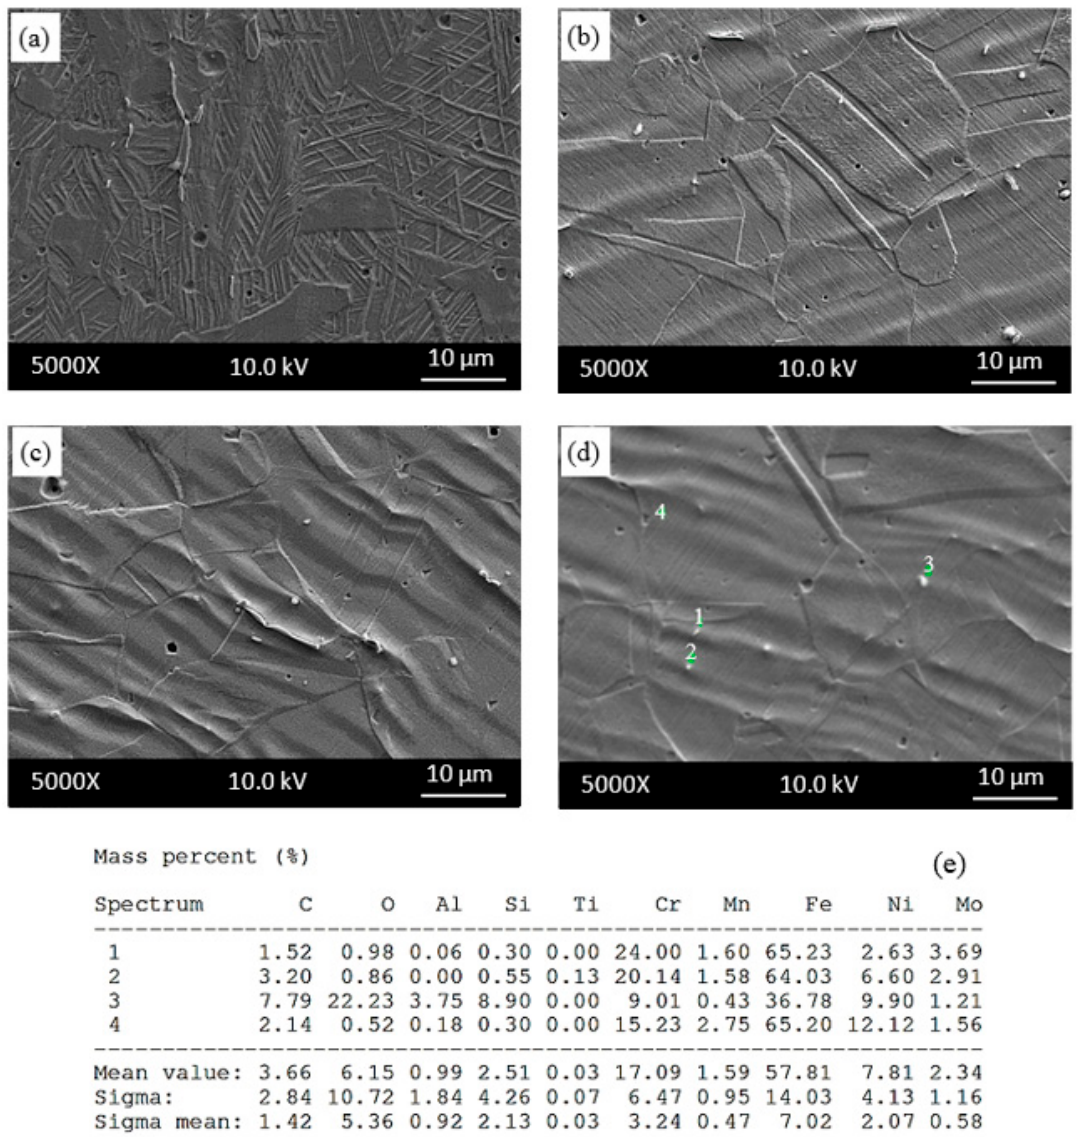
Figure 8. SEM micrographs near fracture surface of as-received samples tested at ( a ) 25 °C, ( b ) 200 °C, ( c ) 400 °C, ( d ) 600 °C and ( e ) corresponding energy dispersive spectrometry (EDS) of the indicated particles in samples tested at 600 °C.